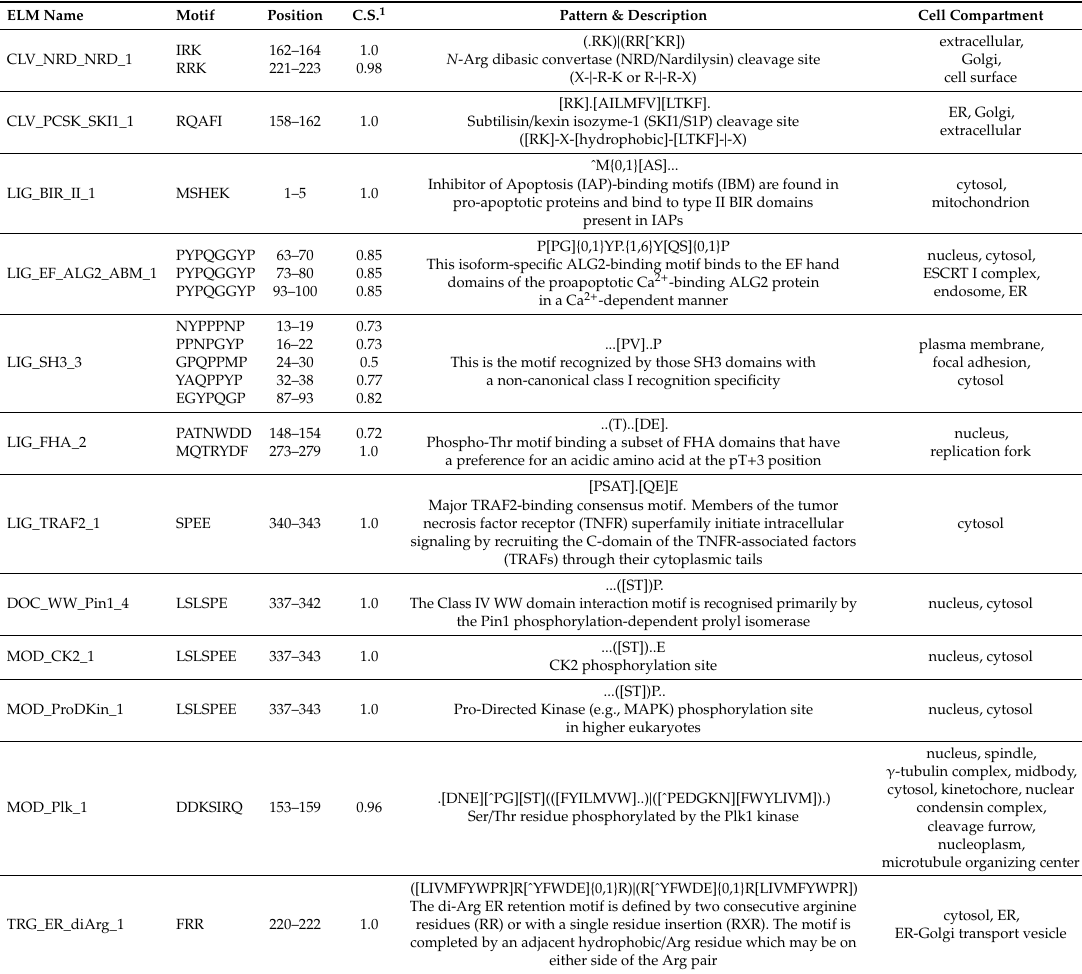
Table 1. List of conserved linear motifs in GRINA from the eukaryotic linear motif (ELM) resource